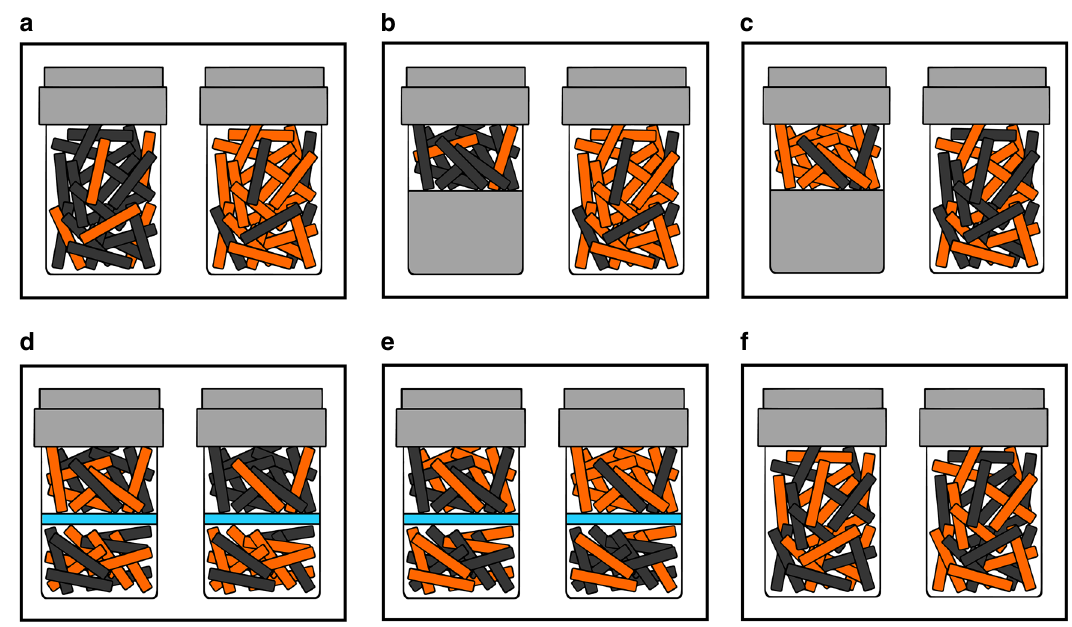
Fig. 1 Token populations used across all experimental conditions. Proportional representation of token populations for Experiments 1 – 3. In the illustrations, orange rectangles represent the unrewarding tokens, and black rectangles represent the rewarding tokens. a – c The token frequencies for Condition 1, Condition 2 and Condition 3. d , e The token frequencies for Experiment 2, with the blue lines representing a physical barrier. f The token frequencies at test for Experiment